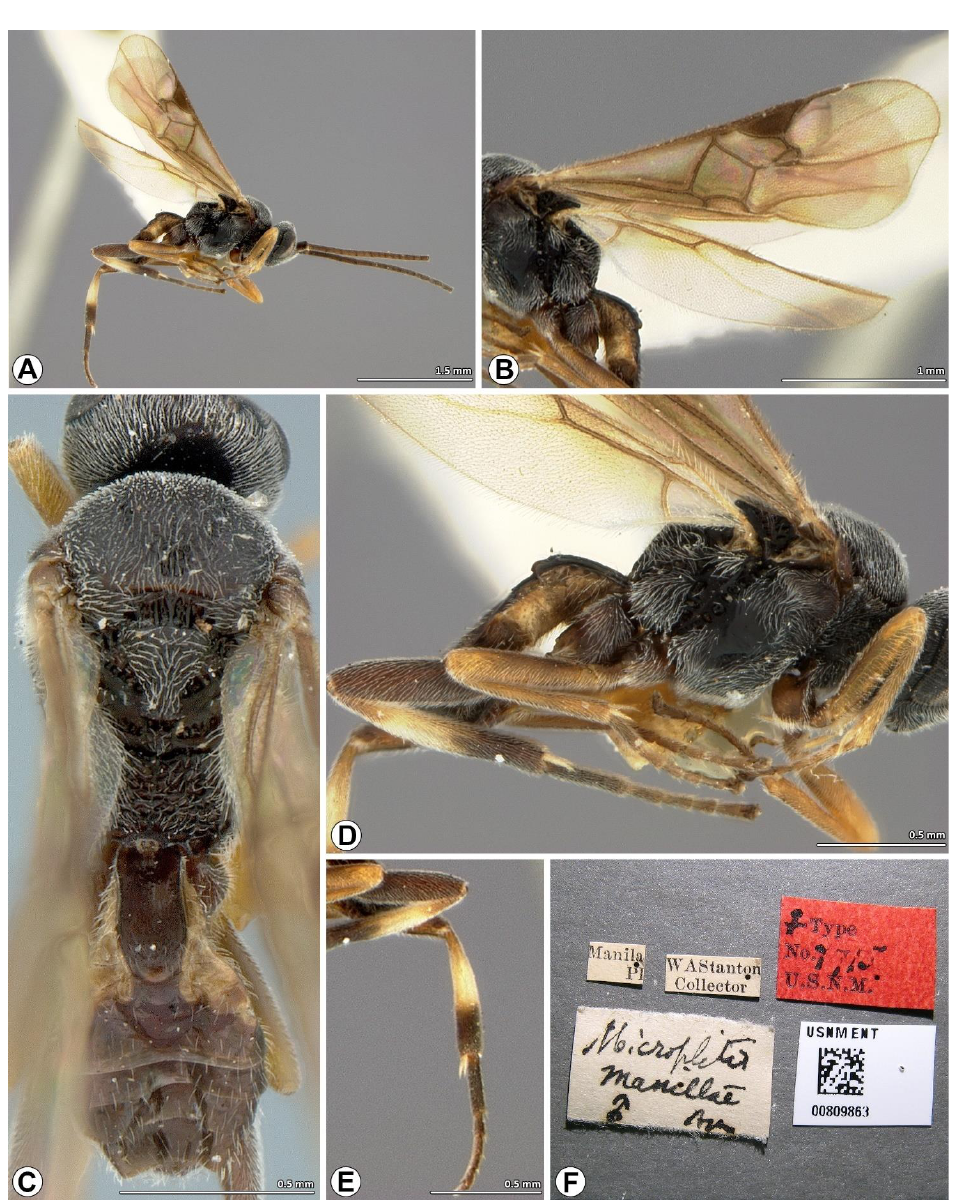
Figure 1. Microplitis manilae Ashmead, 1904, holotype female from the Philippines (USNM). ( A ) Habitus, lateral view; ( B ) wings; ( C ) head, mesosoma, and metasoma, dorsal view; ( D ) mesosoma and metasoma, lateral view; ( E ) hind leg; ( F ) holotype labels.